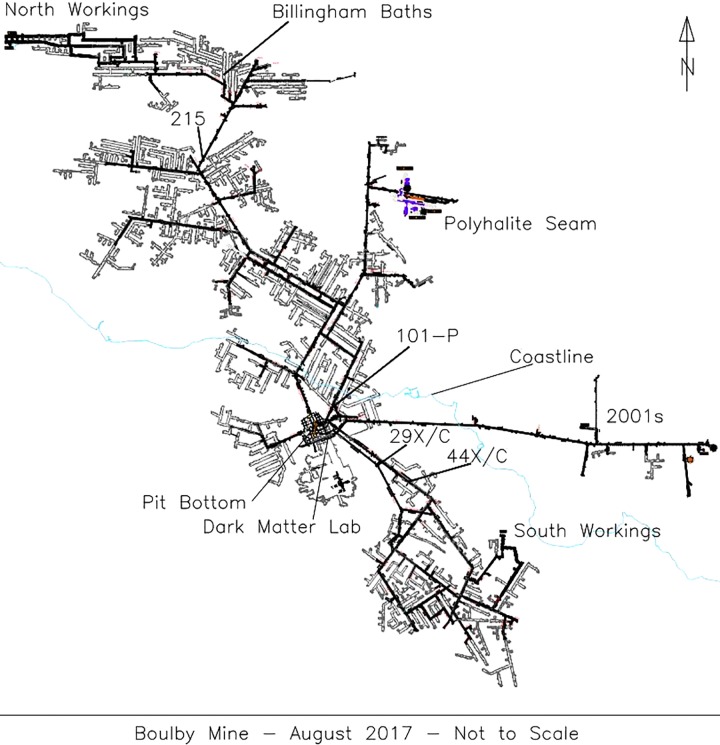
A schematic of Boulby mine in August 2017 with the locations of the brine seeps collected during this study. The coastline is outlined in light blue.